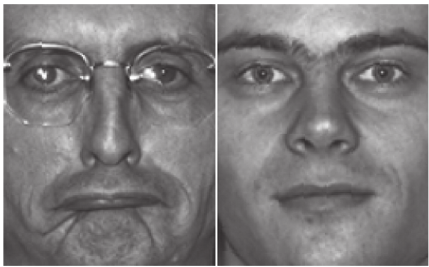
Figure 11: Examples of FERET Database